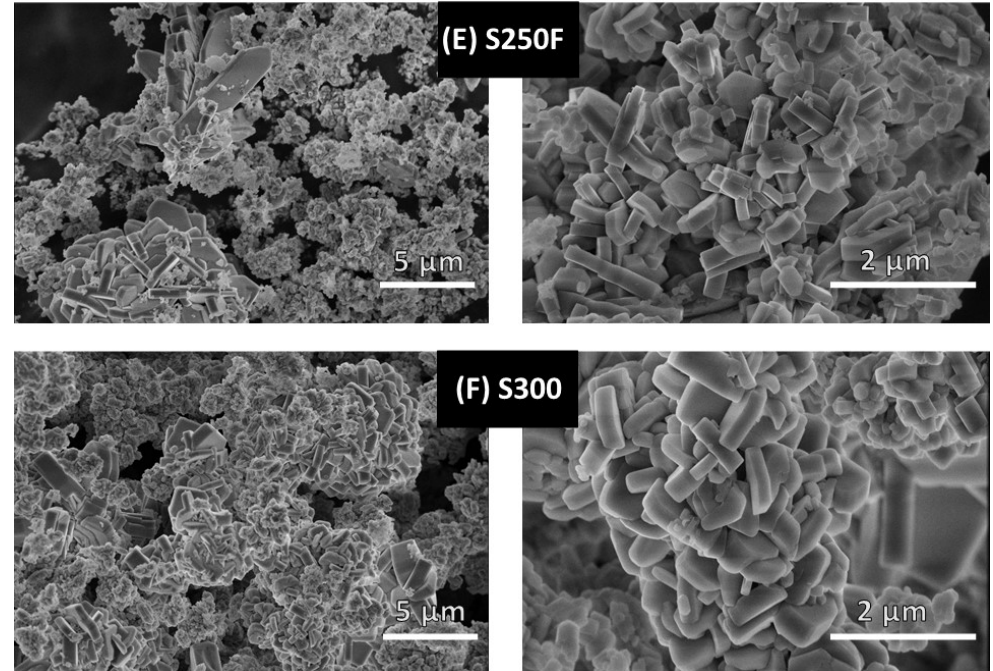
Figure 8 . SEM micrographs corresponding to the following experimental samples: ( A ) S50F, ( B ) S100F, ( C ) S150F, ( D ) S200F, ( E ) S250F, ( F ) S300.